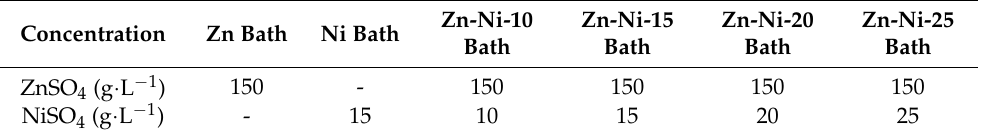
Table 1. Different electroplating bath compositions used to apply pure Zn, Ni metallic and Zn-Ni alloy coatings.